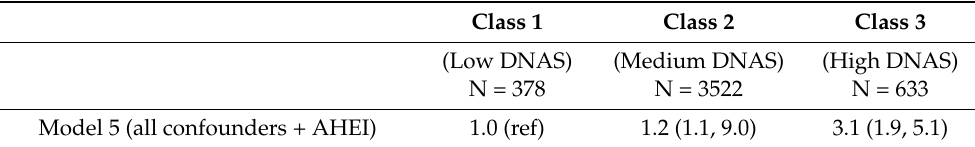
Table A3. Hazard Ratios (95% Confidence Interval) of all-cause mortality for classes identified by latent class trajectory model.